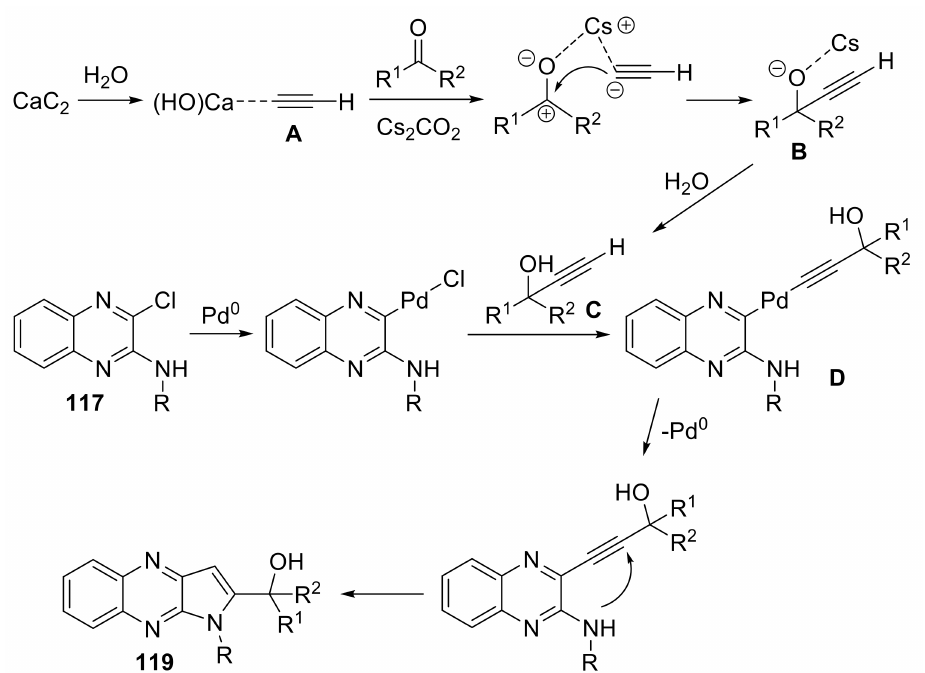
Scheme 66. Proposed mechanism of three component